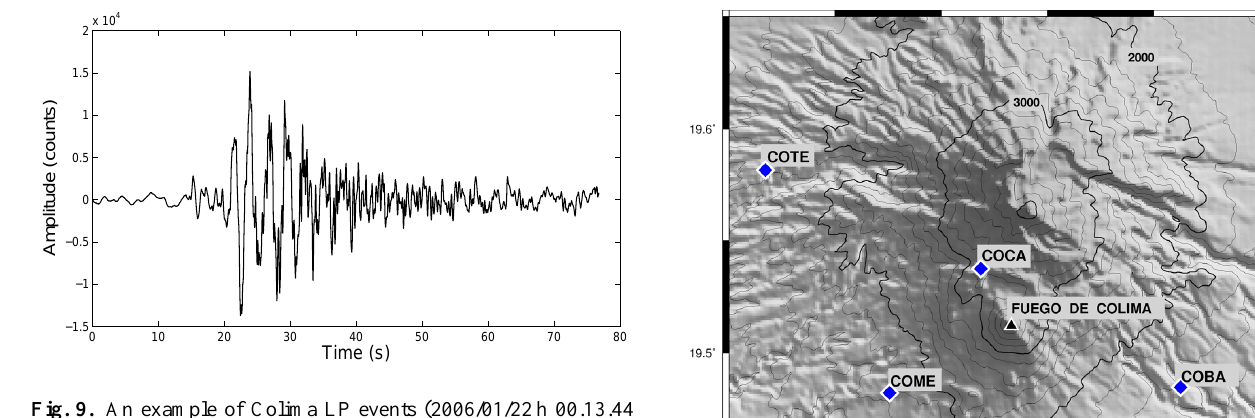
Fig. 9. An example of Colima LP events (2006/01/22h 00.13.44 vertical component).